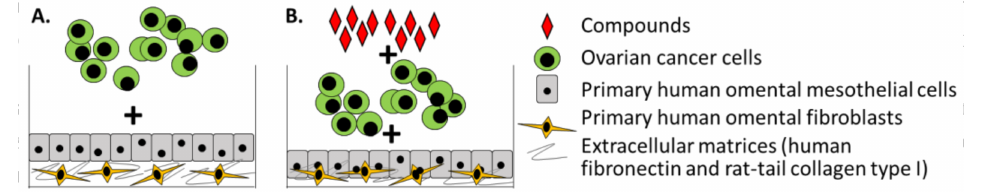
Figure 2. Three-dimensional organotypic model of human mesothelium. ( A ) Layered model for investigating ovarian cancer adhesion, migration, invasion and proliferation in a metastatic microenvironment. In this layered model, the extracellular matrix (ECM) and fibroblasts are cultured together prior to the sequential addition of mesothelial cells and cancer cells. ( B ) Model for high-throughput screening (HTS) to identify compounds that inhibit ovarian cancer adhesion/invasion or proliferation. In this HTS model, ECM, fibroblasts and mesothelial cells are plated simultaneously, followed by the addition of cancer cells and